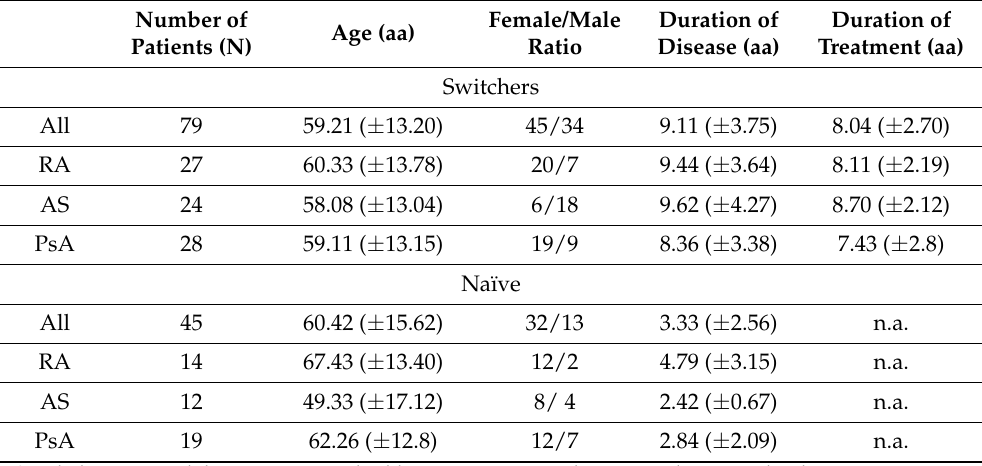
Table 1. Demographic and clinical data of switchers and naïve patients (values expressed in mean ± DS). Number of Patients